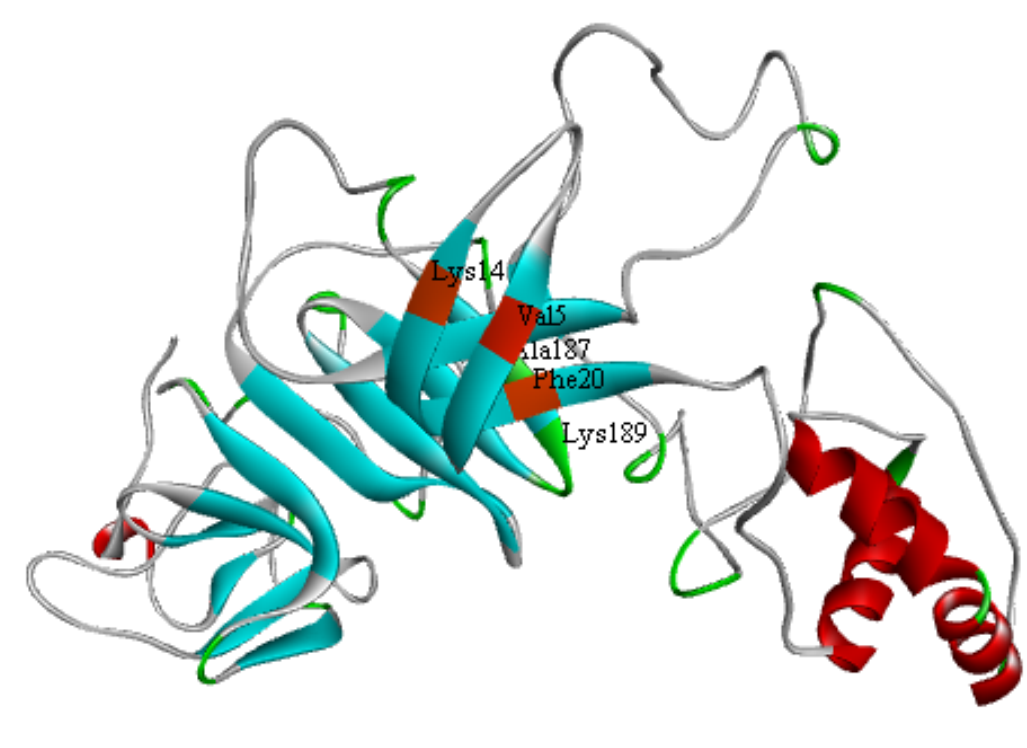
FIGURE 2 - Tertiary structure of DENV4-NS1 with predicted binding